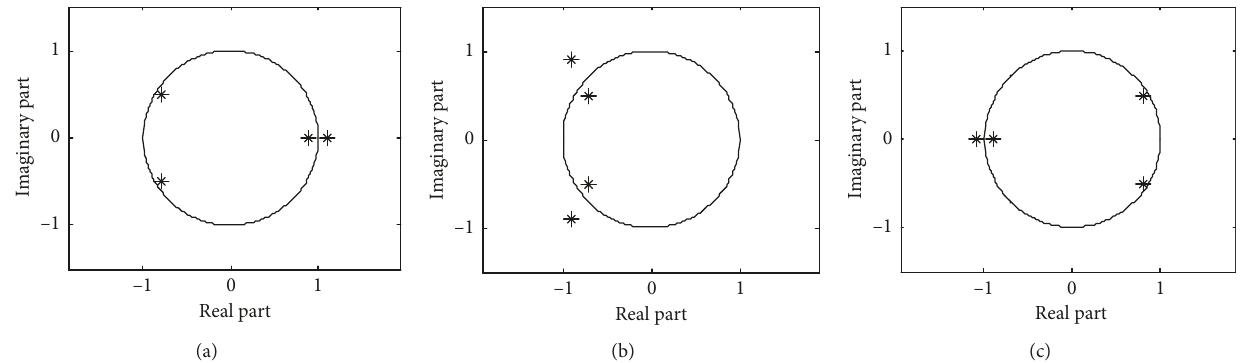
Figure 4: Eigenvalues on the complex plane corresponding to the three types of bifurcation: (a) fold; (b) Hopf; (c)